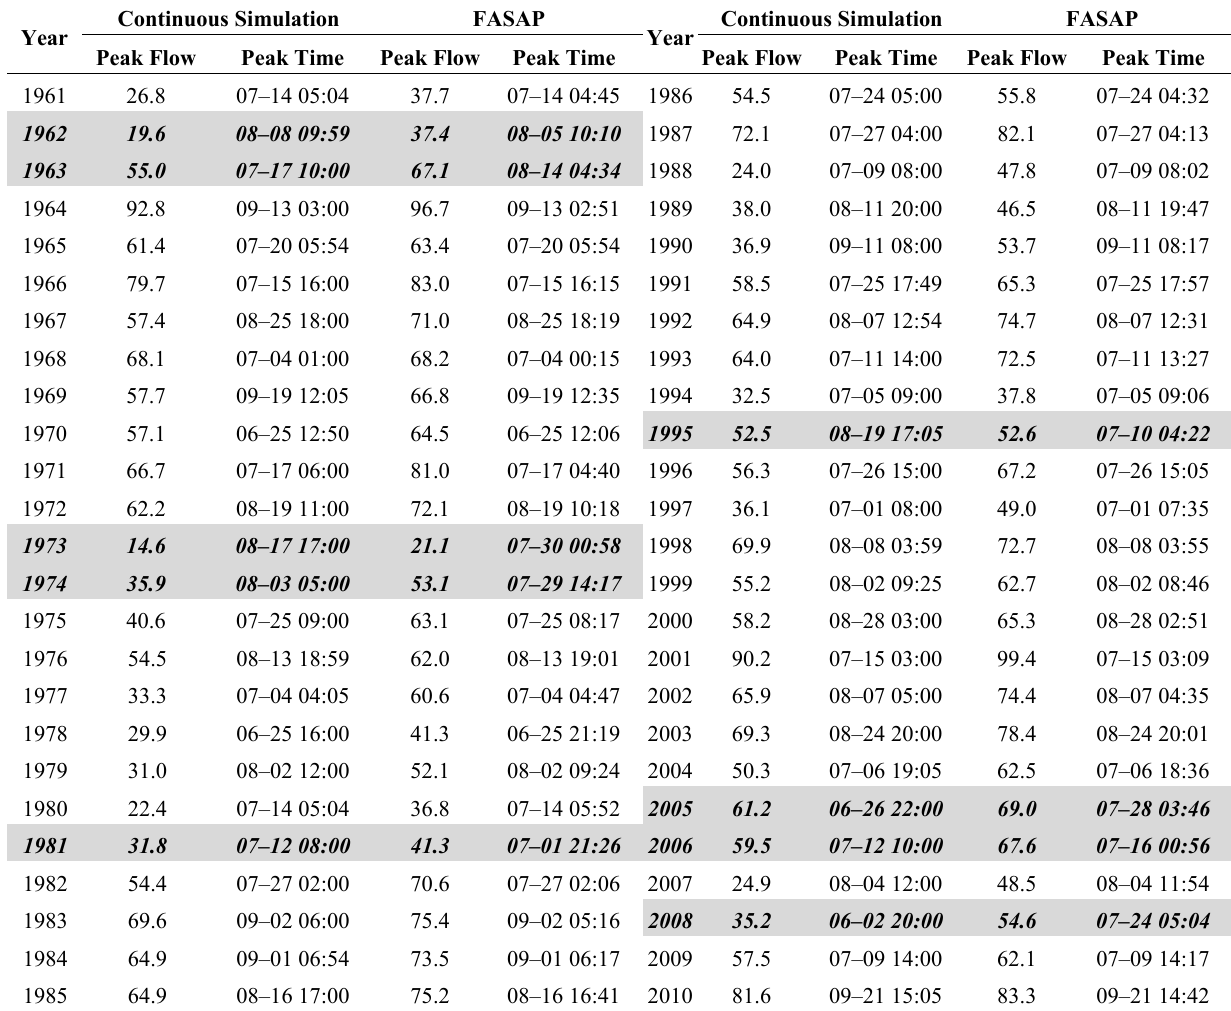
Table 10. The simulated annual peak flows and the peak times of continuous simulation and